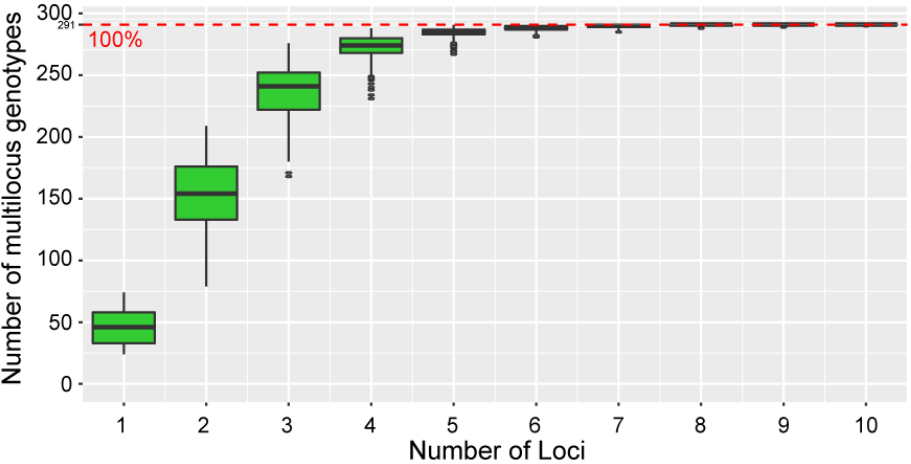
Figure 2. Relationship between the number of multilocus genotypes and the number of loci in 291 individuals of the spring orchid. When the number of loci was seven or higher, the 291 individuals could be 100%